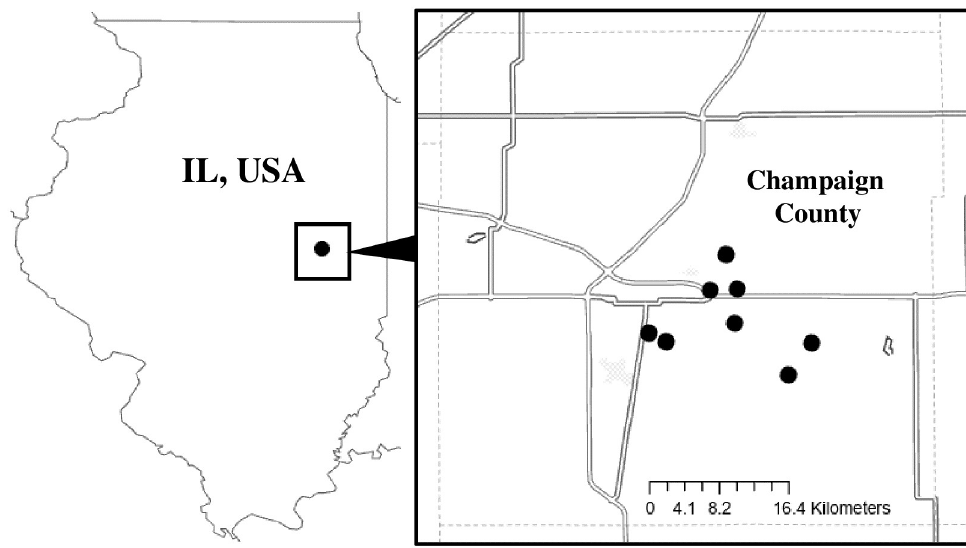
Fig 1. Location of apiaries in Champaign county Illinois, USA over the winter of